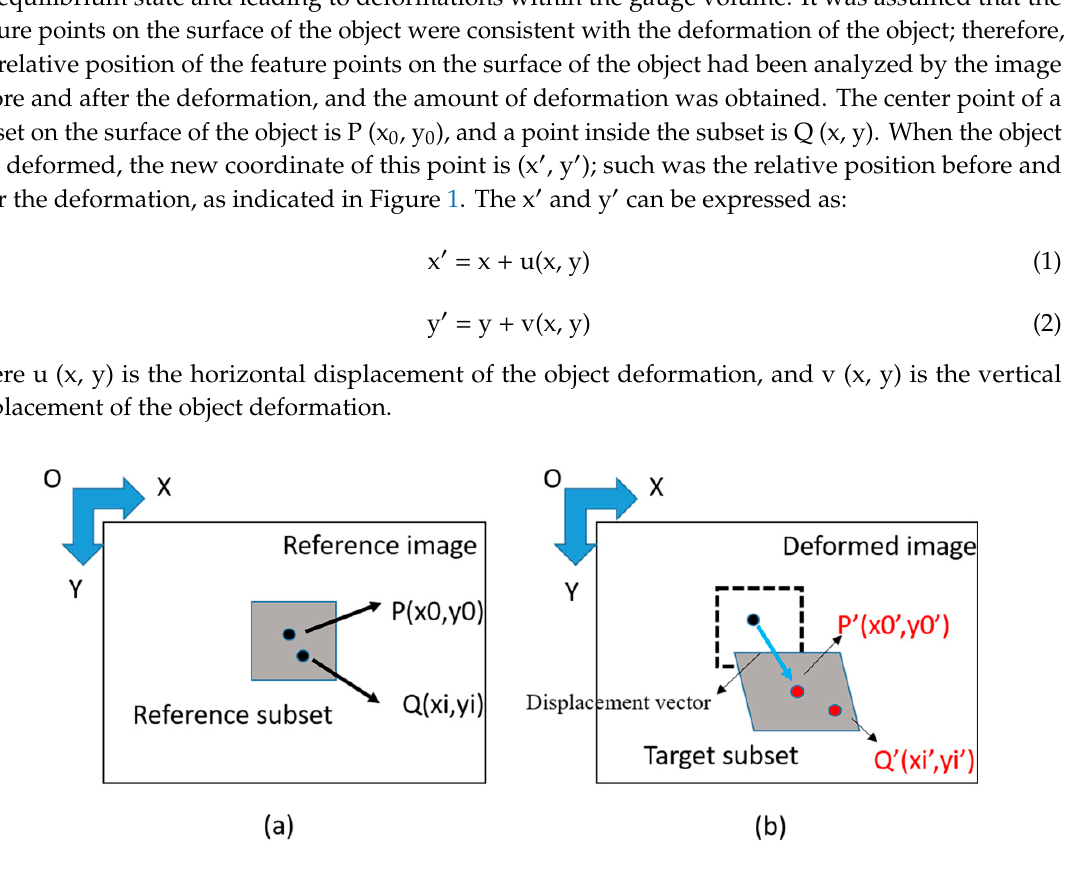
Figure 1. The position of the object ( a ) before deformation ( b ) after deformation [18].